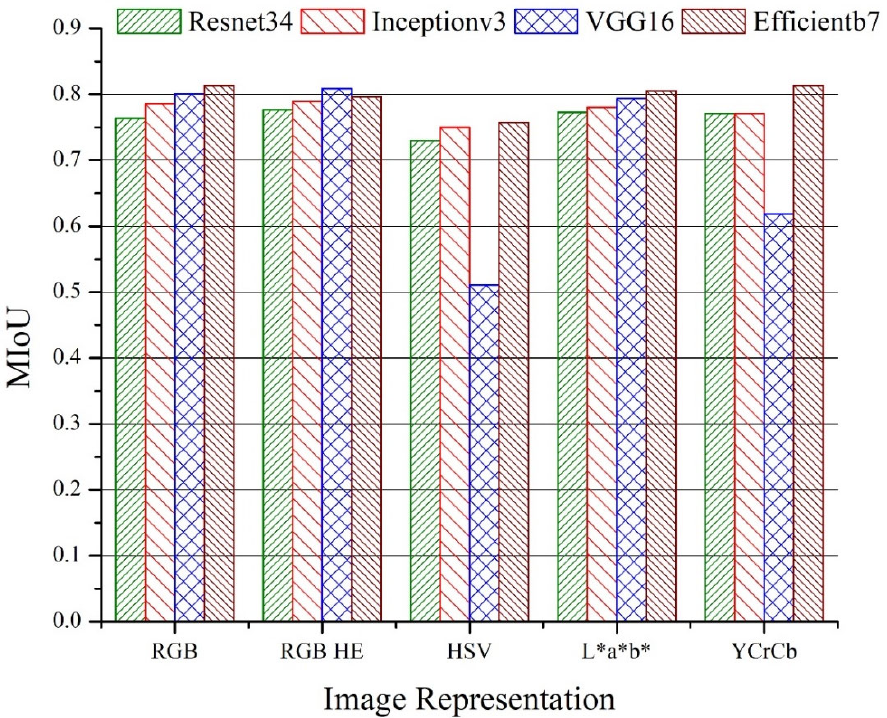
Figure 8. Mean intersection of union (MIoU) for LinkNet models with different backbones and image color representations for test data.